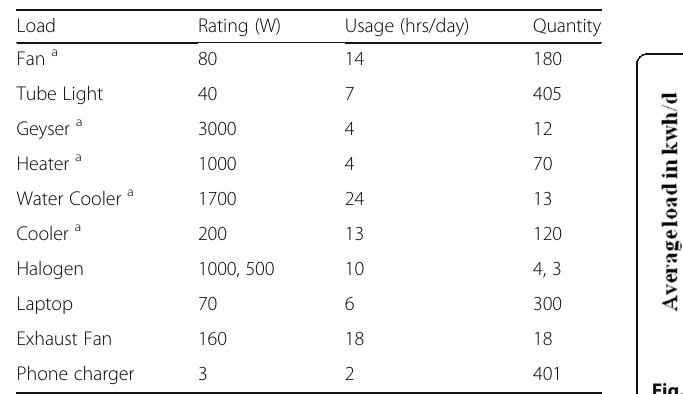
Table 1 Approximate Daily Electric Load Consumption of